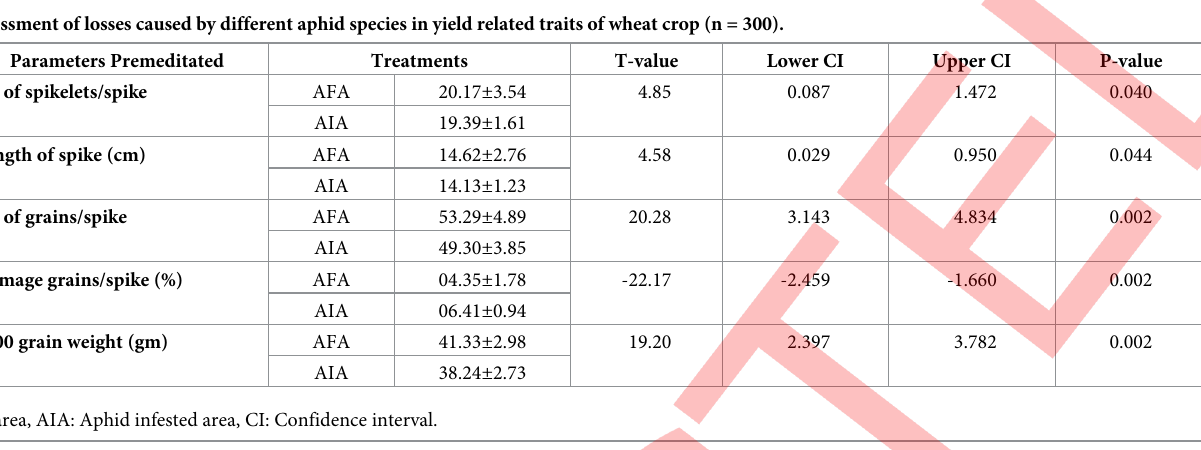
Aphid-free and -infested areas significantly differed for losses caused in the yield-related traits. Higher number of spikelets per spike (0.78), longer spikes (0.49), a greater number of grains/spike (3.99), less damaged grains per spike (2.06) and increased 1000-grain weight (2.49) were recorded for aphid-free than aphid-infested area (Table 2). Elmali and Toros [42] studied several characters, i.e., 1000 grain weight, spikelets per spike, grain per spike, plant height and spike length to estimate losses where 10.16% loss in 1000-grain weight, 6.70% reduction in length of spike and 1.22% reduction in tiller length was recorded. Sitobion avenae was most damaging species for the grains by causing huge loss in spike biomass for wheat crop [42–45] that deteriorates the flour quality in baking industries. Pearson correlation revealed that weather attributes were non-significantly correlated with aphid infestation in tested genotypes during both years of study. Maximum temperature has weak negative association with aphid population, whereas all other abiotic factors correlated positively (but weak) with aphid population (Table 3). Similarly, correlation analysis of aphid population with yield-related traits in aphid-free and -infested area was also statistically non-significant. In aphid-free area, number of spikelets per spike and damaged grains per spike showed weak negative correlation with the aphid pop- ulation, while other parameters behaved positively. In aphid-infested area, only number of grains per spike had negative correlation with aphid population, whereas other tested parame- ters demonstrated positive association (Table 4).